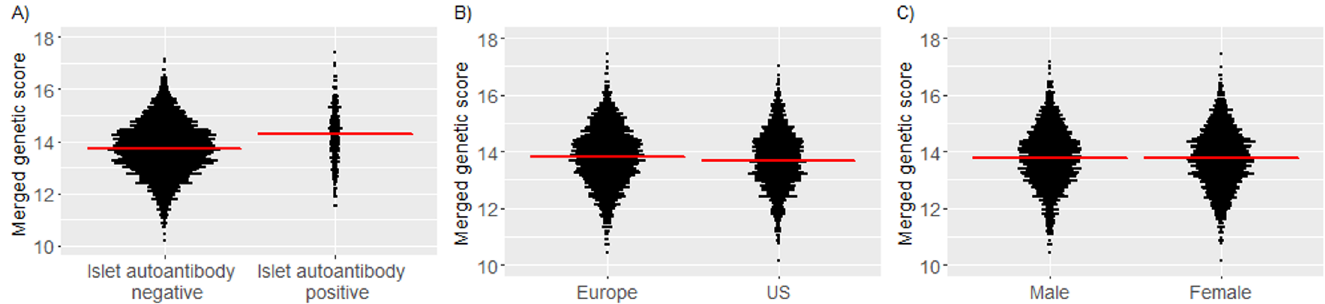
Fig 3. Merged genetic score in TEDDY children according to their islet autoantibody outcome, geographic location, and sex. Islet autoantibody outcome (A); geographic location (B); sex (C). Red horizontal lines indicate the median genetic score value in each group.